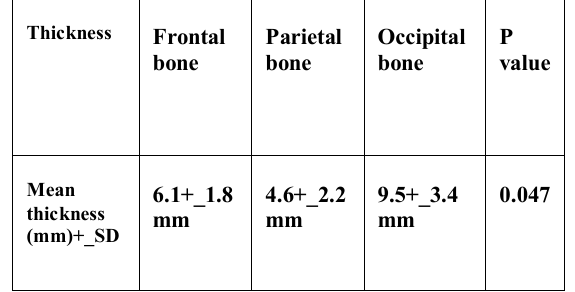
Table 1: Comparison of mean thickness of Frontal, Parietal and Occipital